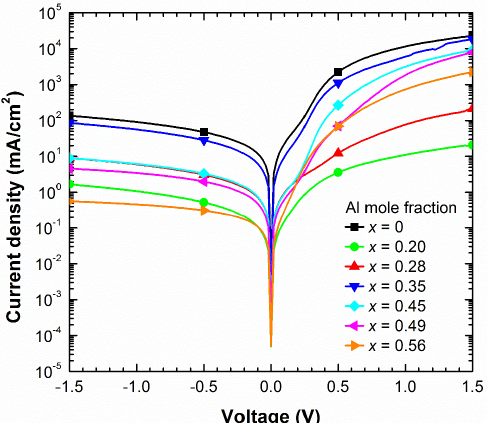
Figure 4. Current density vs voltage curves in the dark of the Al x In 1 − x N on Si (100) devices vs the Al mole fraction x.